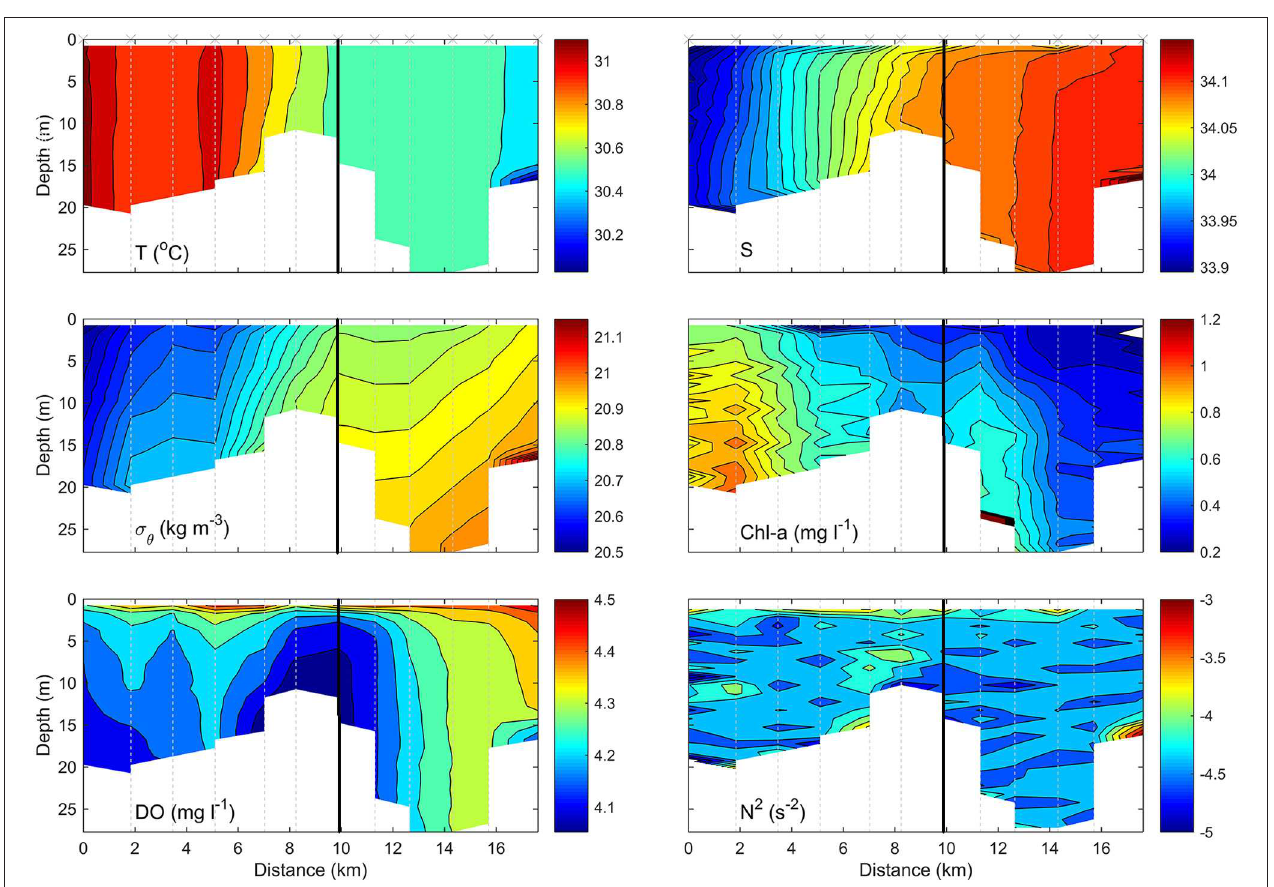
FIGURE 2 | Example CTD transect, of Diego Garcia, indicating changes in temperature (T), salinity (S), density ( σ θ ), chlorophyll- α (chl- α ), dissolved oxygen saturation (DO), and the Brunt-Vaisala frequency squared (N 2 ) with depth (m) and horizontal position (km). Black line indicates exposure boundaries, left (inner) and right